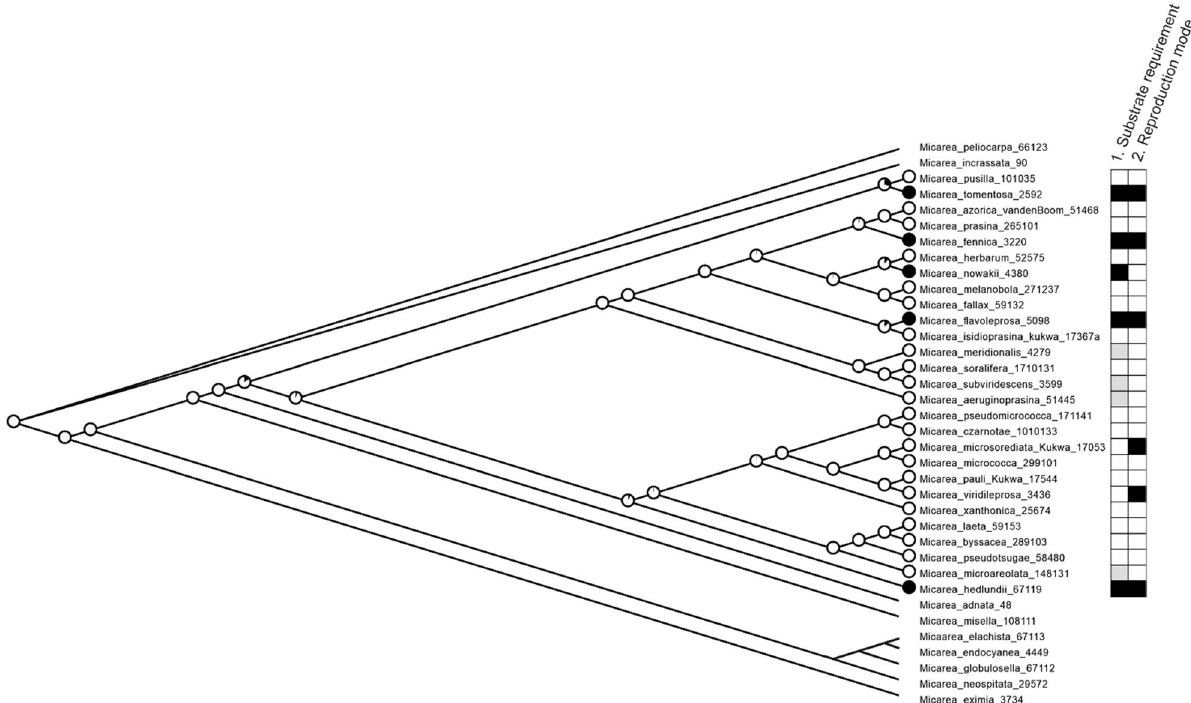
Figure 3. A maximum likelihood phylogram depicting ancestral character state reconstruction of the evolution of obligate lignicoles. Individuals of the same species were pruned and collapsed at the branches of the corresponding nodes. Pies represent probabilities of each ancestor being in two potential states for obligate lignicole (yes = black, no = white). In addition, substratum requirement and reproduction mode are mapped with black, grey and white boxes at the tips of the tree as follows: 1. Substratum requirement: black = obligate lignicole; white = facultative lignicole; grey = never found on dead wood. 2. Reproduction mode: black = predominately asexual; white = predominately sexual.